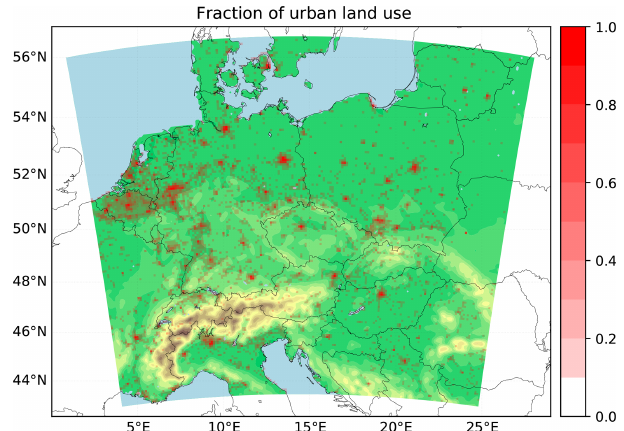
Figure 2. As in Fig. 1 but with red marking urban land-use propor-